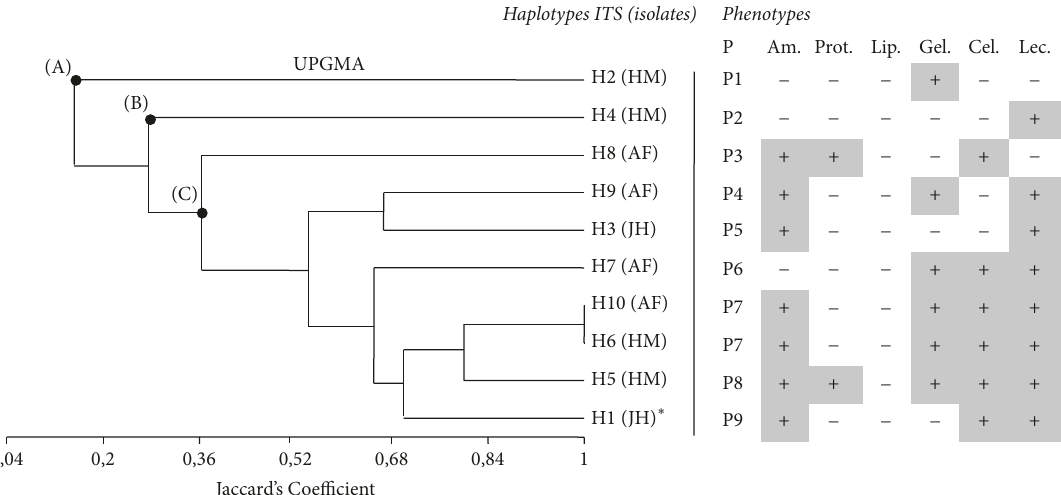
Figure 5: Dendrogram of enzymatic characteristics of ten bacterial strains isolated from hot springs, constructed based on UPGMA cluster analysis and using the Jaccard similarity coefficient. Am.: amylase; Prot: protease; Lip: lipase; Gel: gelatinase; Cel: cellulase; Lec: lecithinase; P: phenotype. * Different strain than Bacillus .